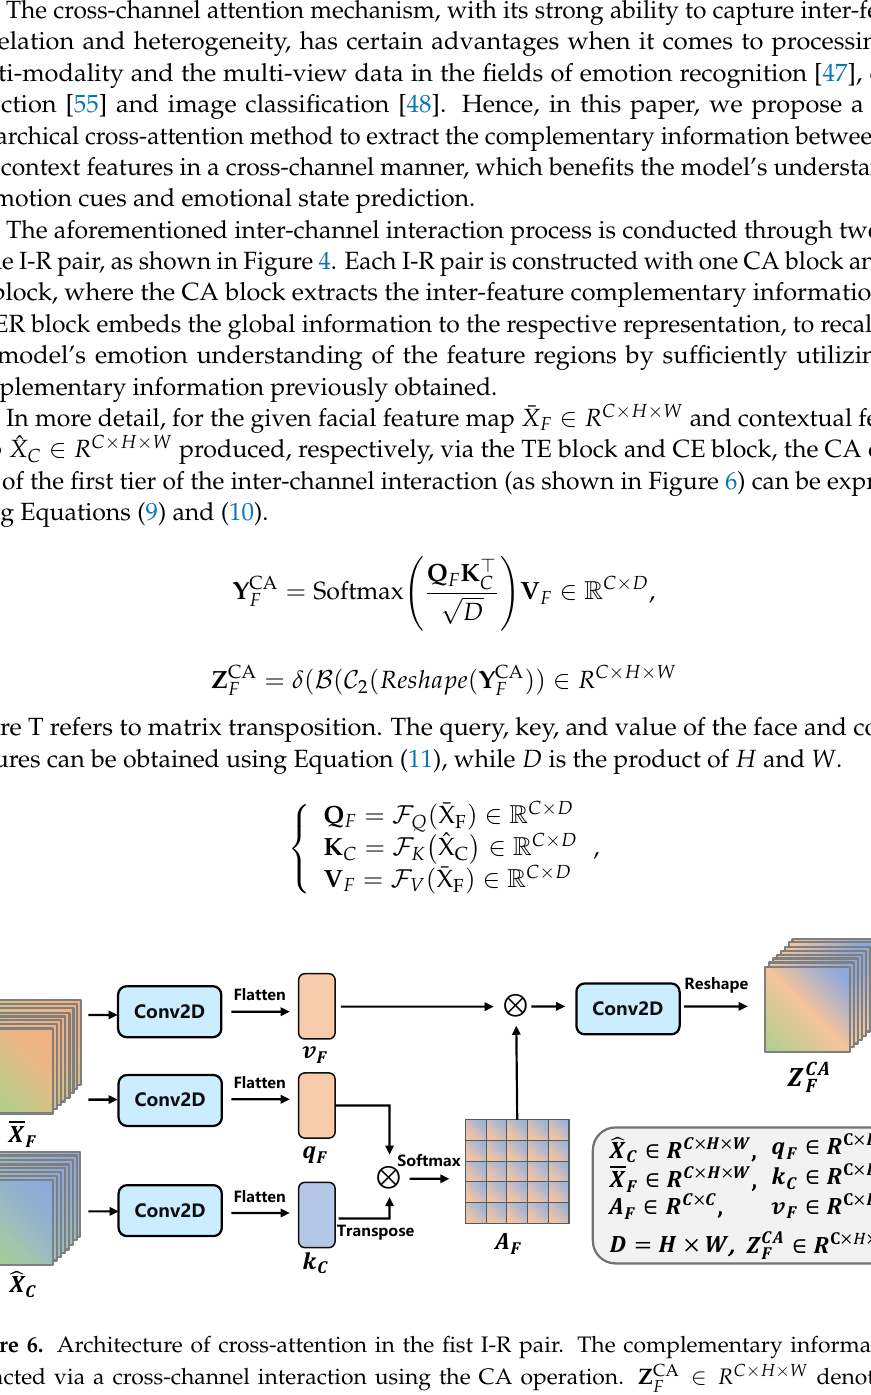
∈ R C × H × W denotes the F